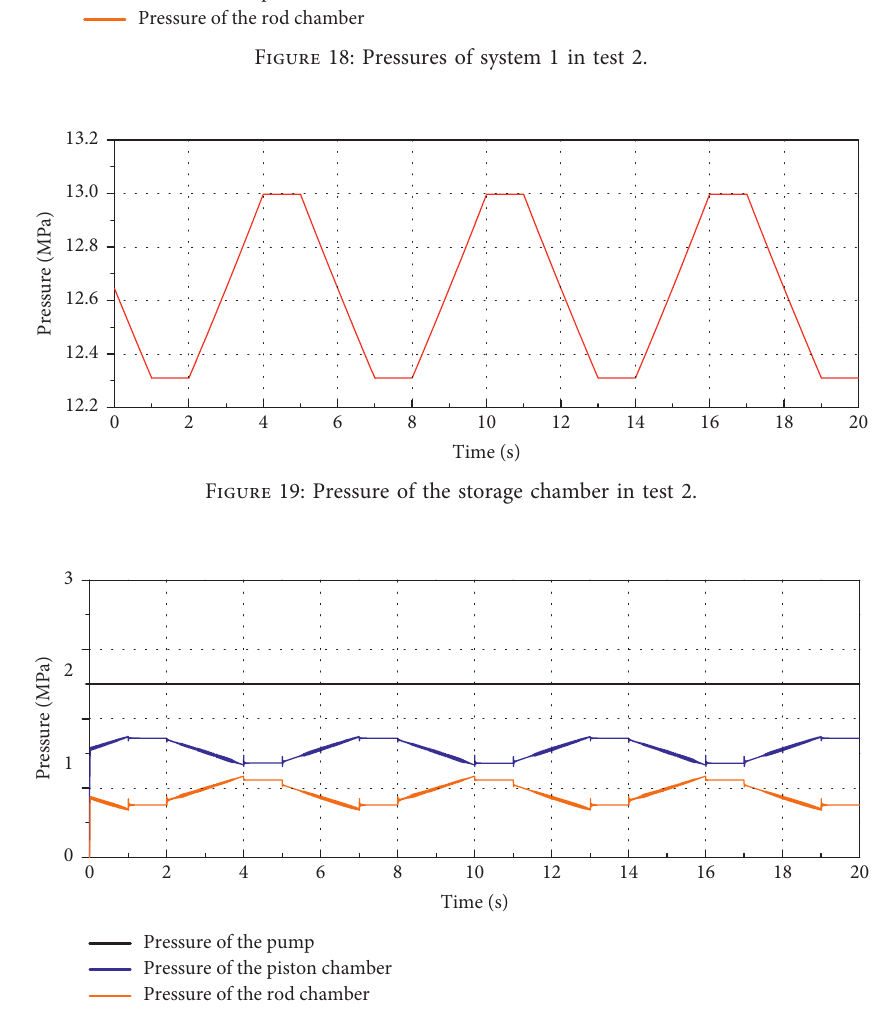
Figure 20: Pressures of system 2 in test